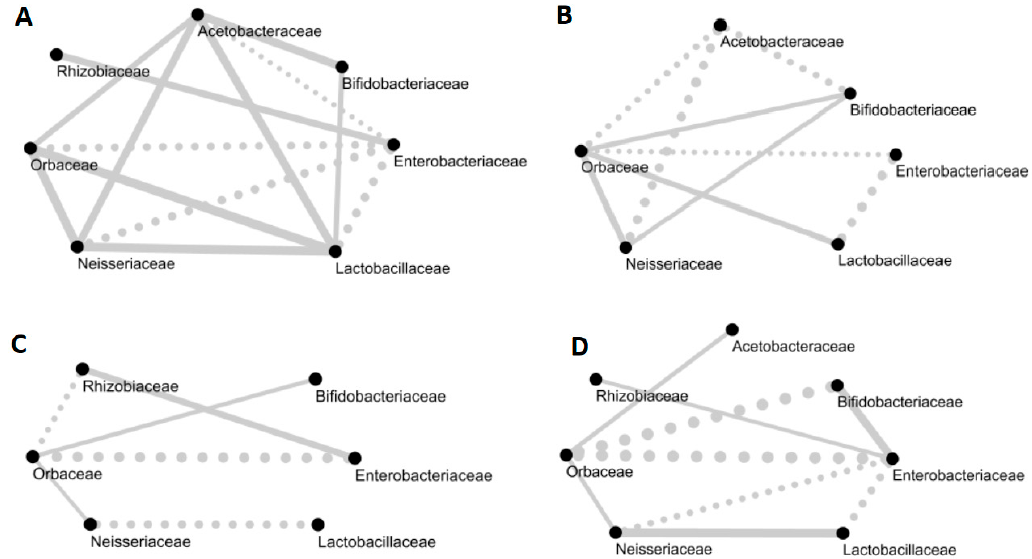
Figure 2. Networks of the core bacterial families of the honeybee gut on ( A ) September 6, ( B ) November 2, ( C ) April 27 and ( D ) June 1. Full lines indicate a positive correlation and dotted lines indicate negative correlations. Correlations under 0.3 are not displayed in the networks. The thickness of the line is proportional to the value of the correlation between two families.